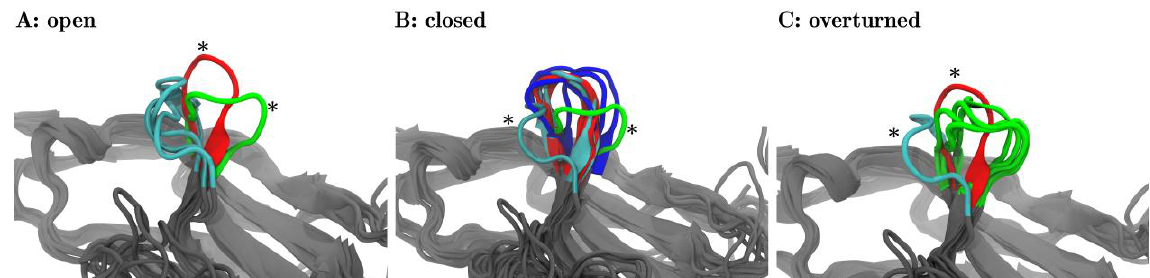
Figure 5. Fleur-de-CC’—Upon pembrolizumab binding the CC’-loop blooms 1 . The central structures of the 25 clusters are superimposed with VMD in groups as they were meta-clustered in the distance map (Figure 4B)—‘open’ ( A ), ‘closed’ ( B ), and ‘overturned’ ( C ). The central frames are colored according to the origins of the structures: PD-1 Apo (cyan), PD-1 PD-L1 (red), PD-1 Niv (blue), and PD-1 Pem (green). Each panel focuses on a different meta-cluster, A on ‘open’, B on ‘closed’ and C on ‘overturned’. In each panel, all of the central frames are displayed for the respective meta-cluster. Additionally, for the two remaining meta-clusters, one representative frame is shown as a comparison (marked with an asterisk *). For example: panel A (‘open’) shows the three central structures (cyan) originating from PD-1 Apo , all within meta-cluster ‘open’, cf. the three structures (6, 9, 22) in cyan, labelled ‘open’ in Figure 4. In addition, panel ( A ) shows one representative structure of meta-cluster ‘closed’ (in focus in panel B) and one central frame of meta-cluster ‘overturned’ (in focus in panel C) for comparison (marked with asterisks *). 1 : The fleur-de-lis is a stylized lily, used as a decorative design or symbol in the heraldry of Numerous European nations.